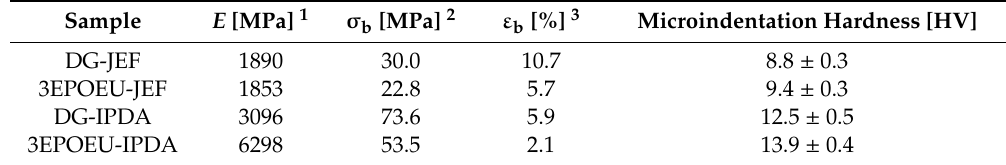
Table 5. Mechanical data of the materials